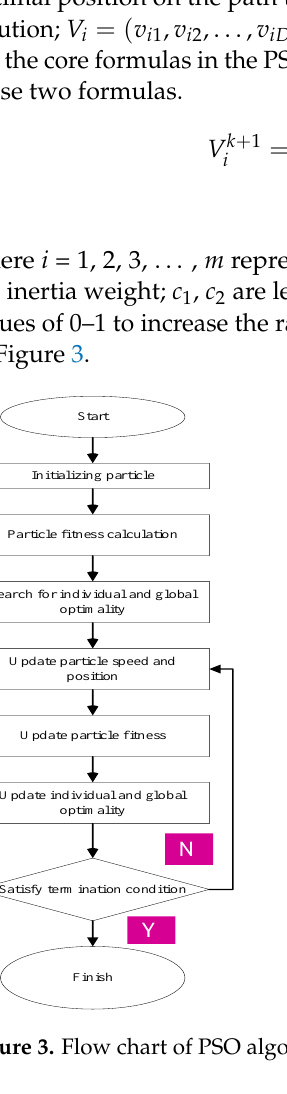
the optimal position on the path that all particles have experienced, that is, the global optimal solution; indicates the velocity of the particle. Formulas (14)